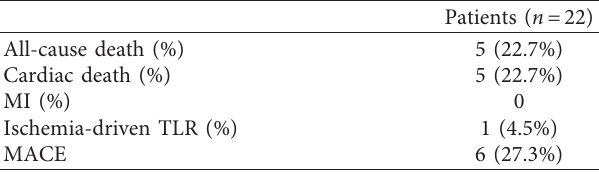
Table 4: Clinical outcomes at